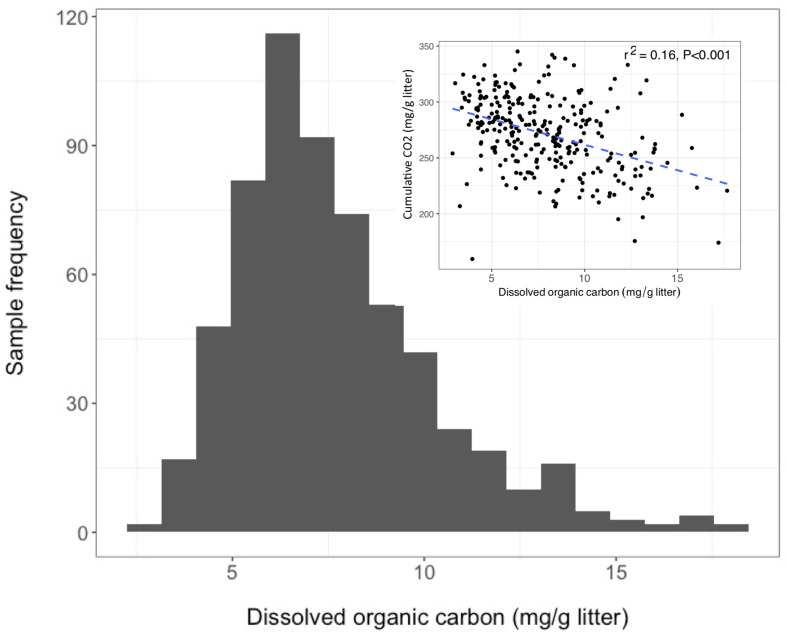
Dissolved organic carbon (DOC) concentrations among 611 microcosms after 44 days of pine litter decomposition. Inset panel - inverse correlation between CO2 and DOC.